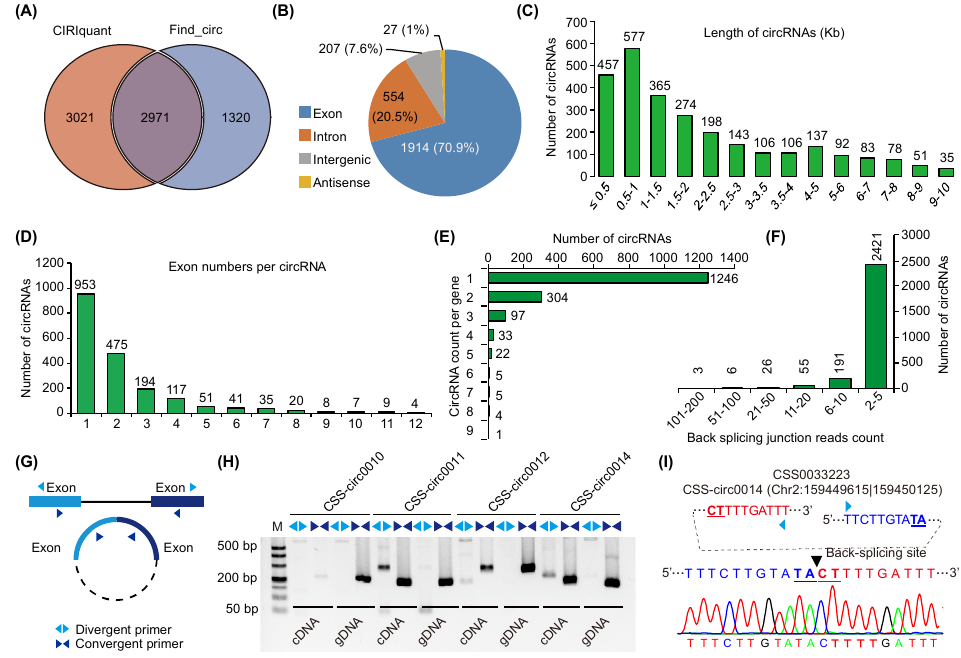
Figure 1. Characteristics and sequence validation of tea plant circRNAs. ( A ) Two state-of-the-art tools (find_circ and CIRIquant) were used for circRNAs identification in tea plant. ( B ) Four major types (exon, intron, intergenic, and antisense) of the identified circRNAs. ( C ) Length distribution of the circRNAs. ( D ) Number of exons harbored by the circRNAs. ( E ) CircRNA counts produced from parental genes. ( F ) Back-splicing junction reads count of circRNAs. ( G ) Design method of convergent and divergent primers. ( H ) PCR amplification of the random selected circRNAs for validation. ( I ) Sanger sequencing validation of the back-spliced sites of circRNA use CSS0033223 as an example.